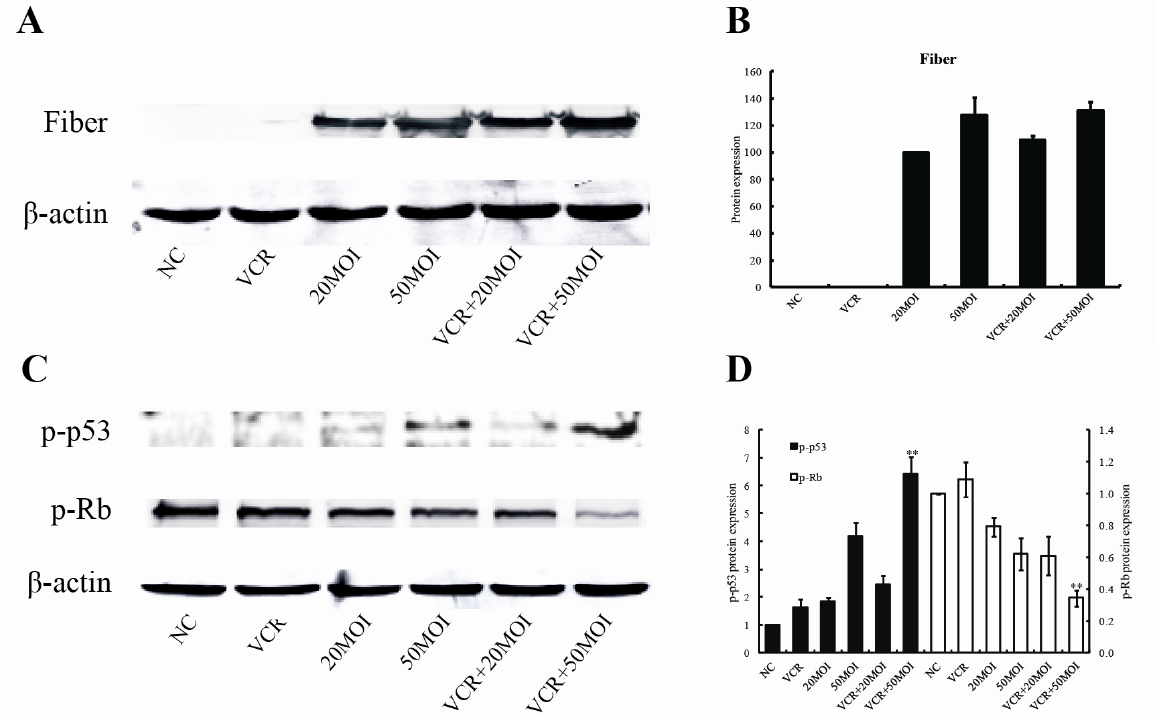
Figure 6. The expression patterns of Fiber, phospho-p53 and phospho-Rb in HXO-RB cells after different treatments for 48 h. ( A ) Western blot analysis of Fiber protein expression at 48 h; ( B ) Average band density of quantified Fiber protein after normalization to the internal control β -actin. Protein expression of Fiber in the SG600 (20 MOI) treatment group was arbitrarily set as 100; ( C ) western blot analysis of p-p53 and p-Rb protein expression at 48 h; ( D ) average band density of quantified p-p53 and p-Rb protein after normalization to the internal control β -actin. Protein expression of p-p53 and p-Rb in the NC group was arbitrarily set as 1. ** p < 0.01 relative to p-p53 and p-Rb protein expression in the SG600 or VCR (5 nM) treatment group. NC (negative control): treatment with